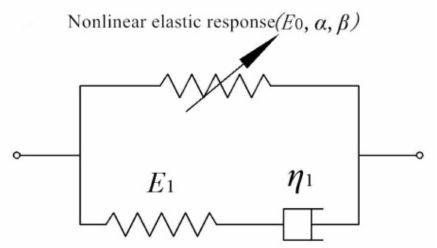
Figure 9. Simplified model of damping alloy